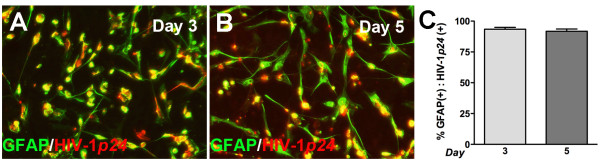
Transfection efficiency of HIV-1YU-2 gene expression plasmid in cultured human astrocytes. To assess the transfection efficiency of cultured human astrocytes with HIV-1YU-2, astrocytes were transfected with 0.3 μg/1.5 million cells using the Amaxa Rat Astrocyte Nucleofector kit and plated in 48 well tissue culture plates at 1105 cells/well. Three and five days post transfection cells were fixed and immunocytochemically labeled with an astrocyte marker, GFAP (green) and HIV-1p24 (red). Seven images were taken from multiple wells of HIV-1YU-2-transfected astroctyes and the number of GFAP positive and HIV-1p24 positive cells in each image were counted independently. The number of cells positive for both markers was then calculated as a percentage. (A) Day three representative image (200x, original magnification), (B) Day five representative image (200x, original magnification) (C) Percent double positive cells following analysis of all images on both day 3 and day 5. An average 90% transfection efficient was achieved with the HIV-1YU-2 gene expression plasmid by this method in cultured human astroctyes.